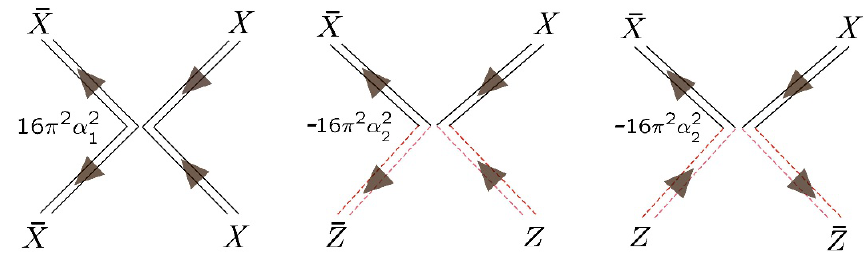
Figure 3 . Feynman rules for all three types of double-trace